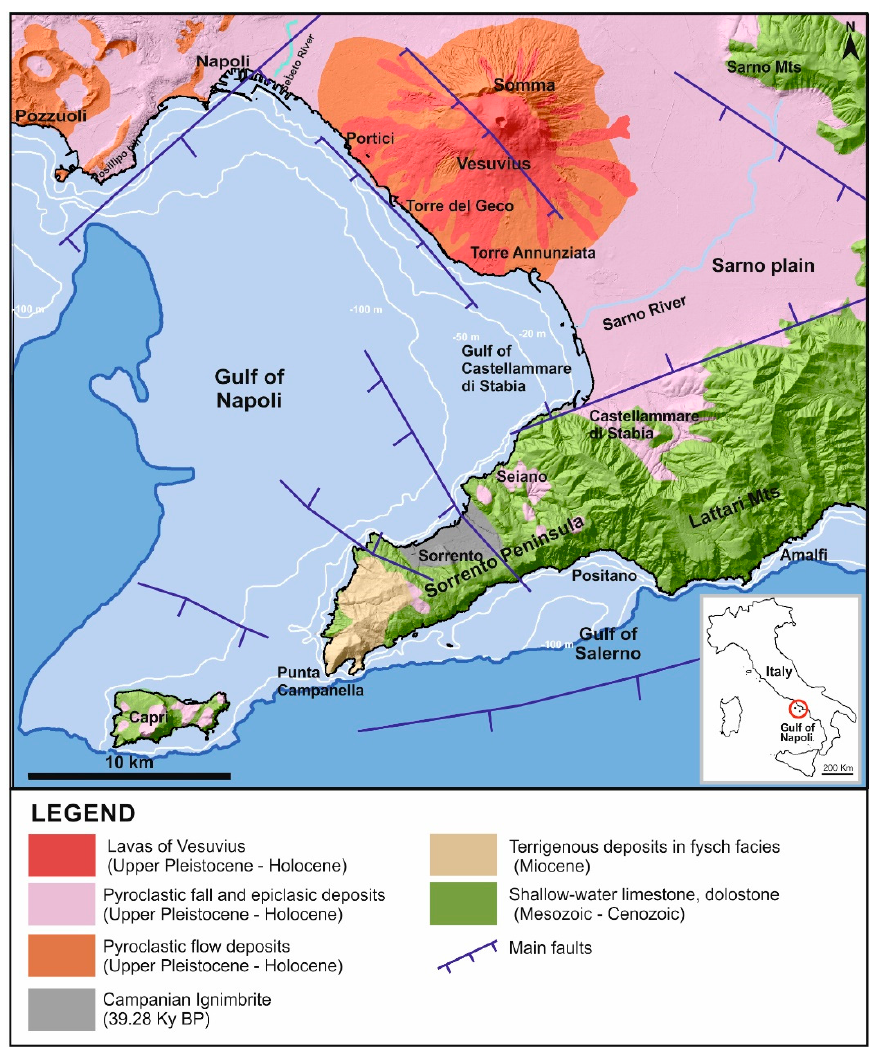
Figure 1. Geological map of Gulf of Napoli, southern Italy (after [5], mod). Inset shows a geographical sketch of southern Italy (the study area is shown in the circle).